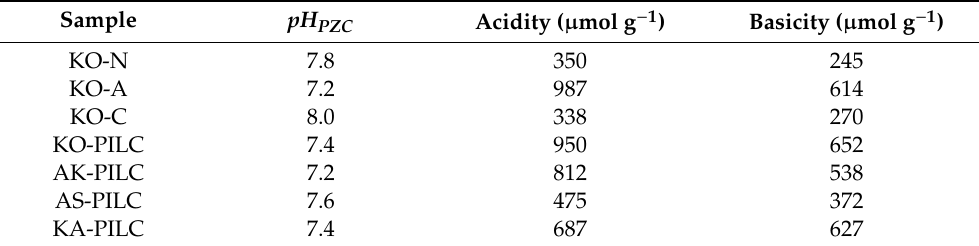
Table 2. Acid-base characterization of the clay-based